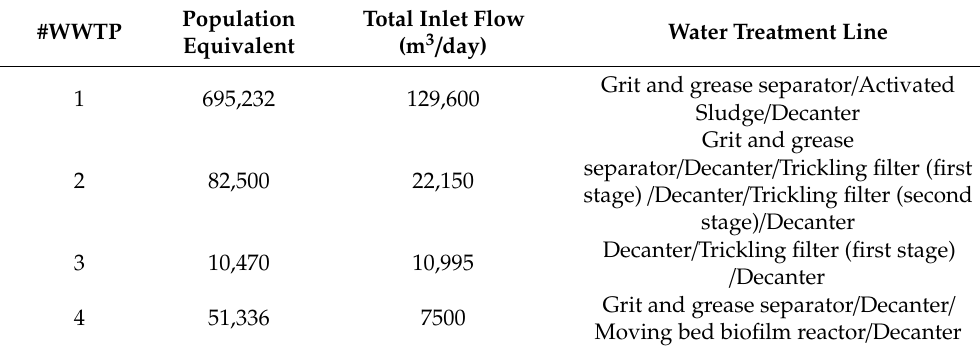
Table 1. Main characteristics of each wastewater treatment plants